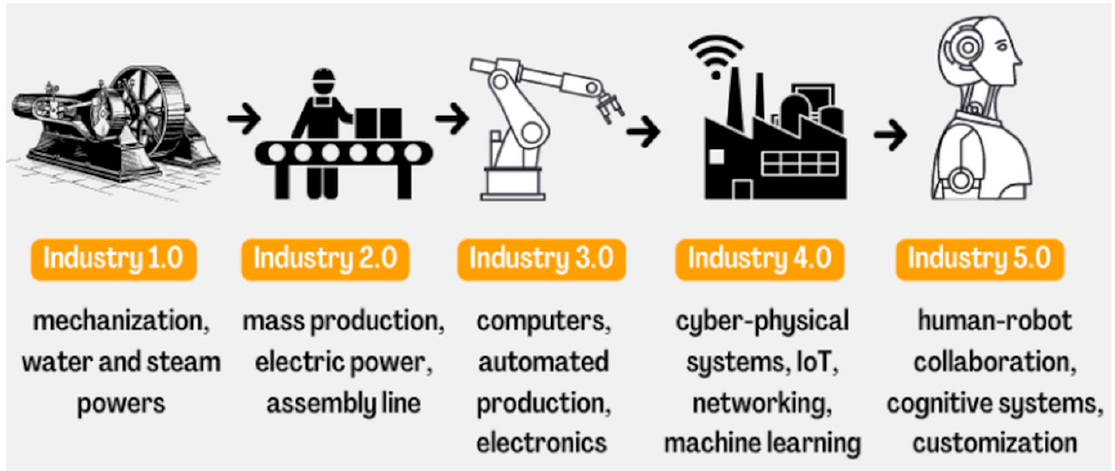
Figure 1. Industrial revolution